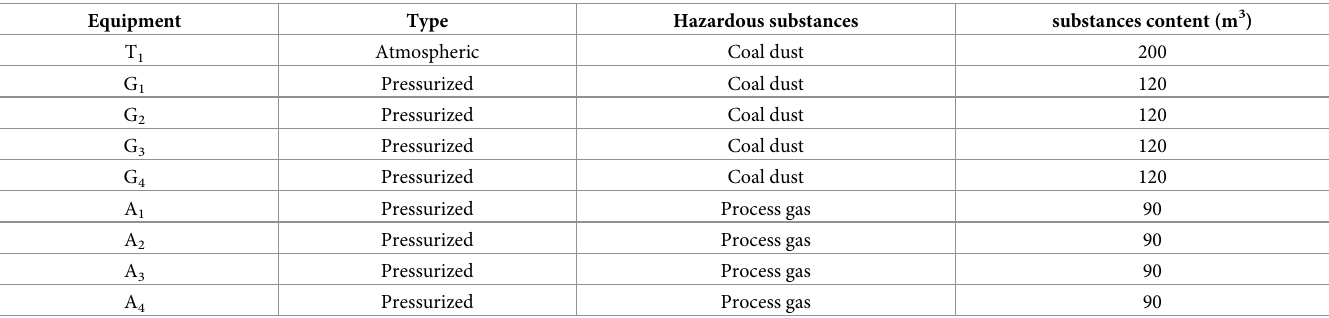
Table 19. The characteristics of the device in the case study [58].